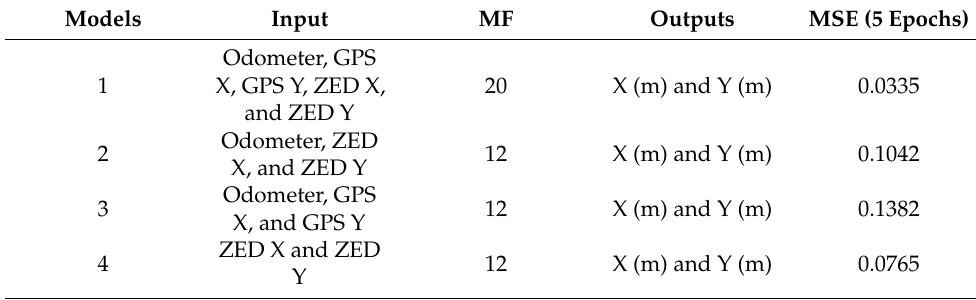
Table 1. Fuzzy models proposed to estimate the distance.